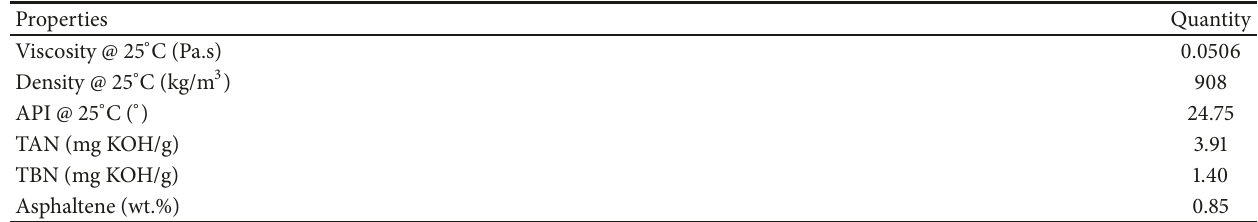
Table 3: Crude oil